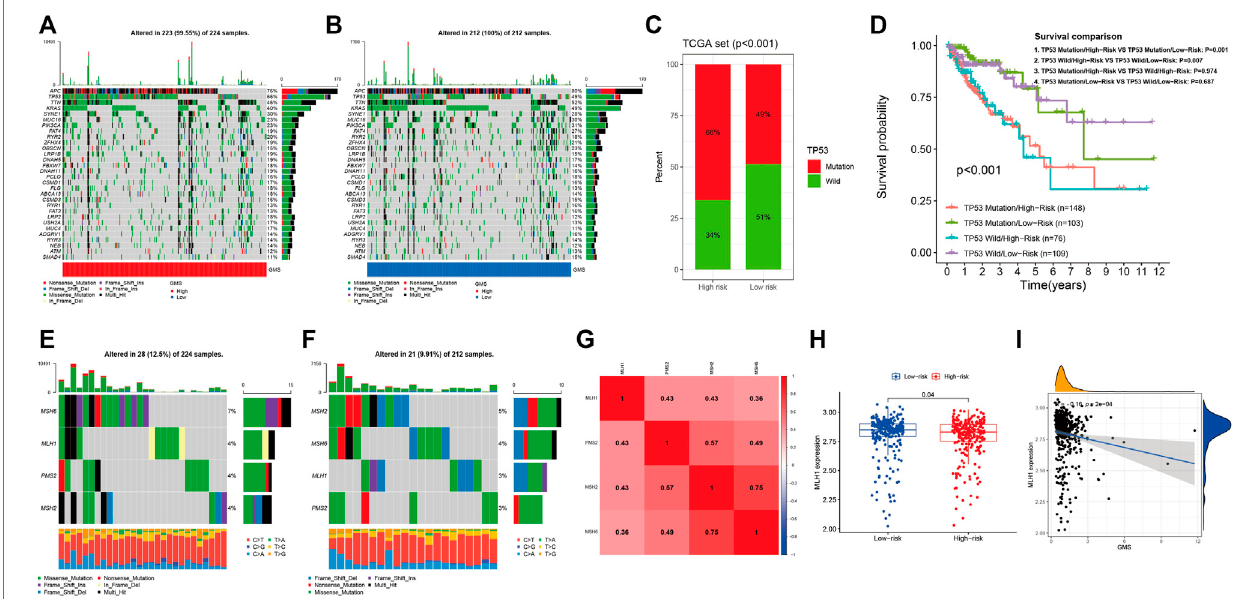
FIGURE 9 | The landscape of somatic mutation and four characteristic genes of MMR system. (A,B) : The waterfall demonstrating the top 30 genes with highest mutationfrequencies. (C) : Thebar plot indicatingthatthe mutational frequencies ofTP53inthe high-riskgroup were higher than thatin thelow-riskgroup. (D) : TheK-M survivalcurvesstrati fi edbythe fi ve-GMRHGprognosticsignatureandTP53mutationalstatus(TP53wildandTP53mutation).TheoverallsurvivalofTCGACRCpatients with TP53 Mutation/High-risk was lower than that with TP53 mutation/Low-risk with statistical differences ( p (cid:1) 0.001). The overall survival of TCGA CRC patients withTP53Wild/High-riskwaslowerthanthatwithTP53Wild/Low-riskwithstatisticaldifferences( p (cid:1) 0.007).Moreover,therewerenostatisticaldifferencesoftheoverall survivalbetweentheTCGA CRC patients inthehigh-orlow-riskgroup withdifferentmutationstatus (TP53Mutation/High-riskVSTP53Wild/High-risk: p (cid:1) 0.974;TP53 Mutation/Low-riskVSTP53Wild/Low-risk: p (cid:1) 0.687). (E,F) :ThewaterfalldemonstratingthemutationalfrequenciesofMSH6,MLH1,PMS2,andMSH2inthehigh-and low-risk high group. (G) : The co-expression correlations among MSH6, MLH1, PMS2, and MSH2. (H) : The expression difference of MLH1 in the high- and low-risk groups. (I) : The positive liner correlation between the expression of MLH1 and the GMS.